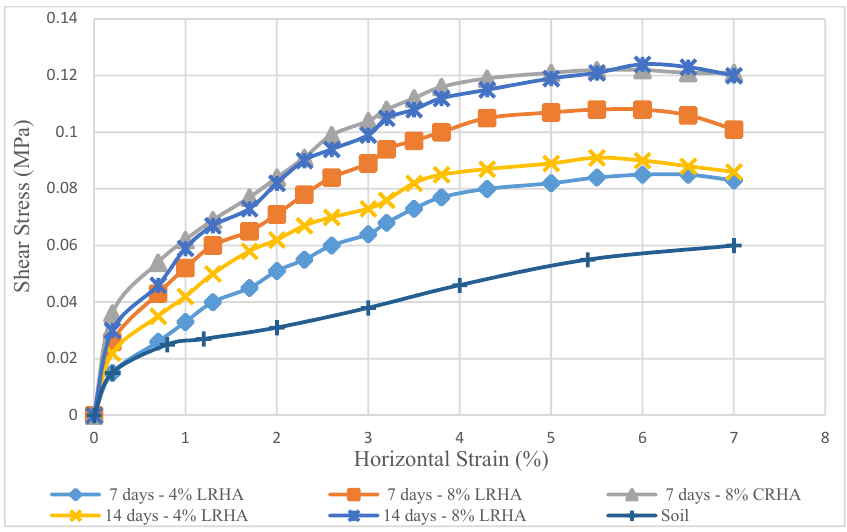
Figure 9. Shear stress to horizontal strains diagram—LRHA 1:2 (vertical stress 0.5 MPa). The strain data accumulated from six tests, obtained from untreated soil and samples treated with LRHA in the lower level (4%) after 7 days curing, showed lower shear stress values than those treated with higher levels of LRHA and longer curing duration. A sim- ilar pattern was obtained by Phanikumar [27] but in higher levels of shear strength. The stabilizer material used was lime sludge mixed with cement.